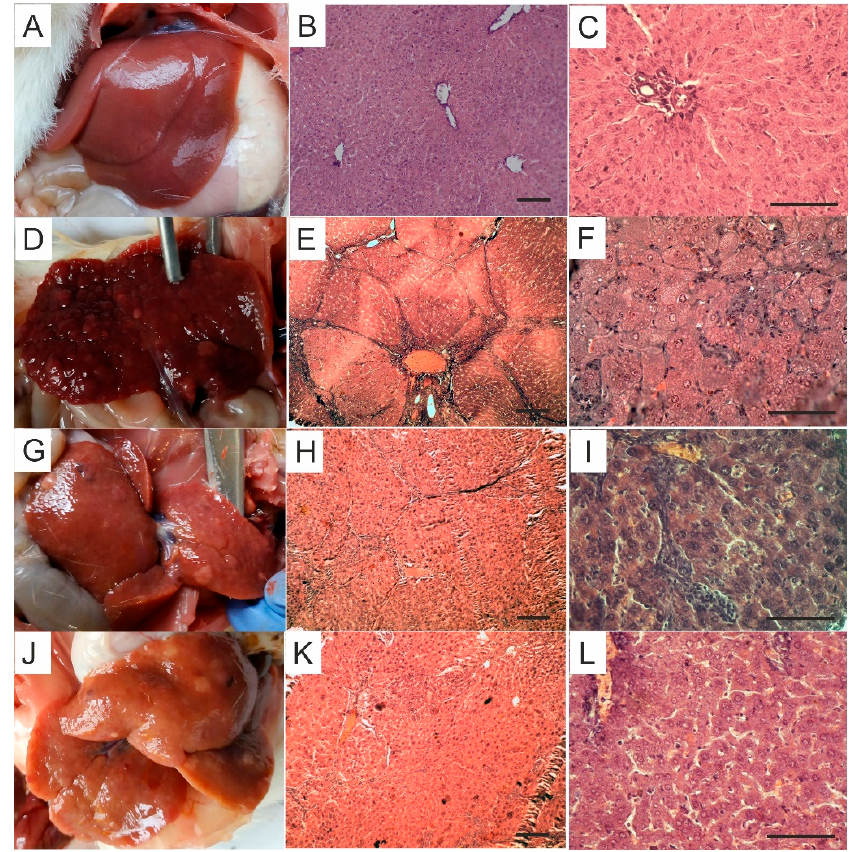
Figure 5. Representative rat livers at the time of the sacrifice ( A , D , G , J ) and H&E staining of liver tissue, magnification ×100 ( B , E , H , K ), scale 200 μ m, and ×400 ( C , F , I , L ), scale 100 μ m: ( A – C )—control; tissue, magnification × 100 ( B , E , H , K ), scale 200 µ m, and × 400 ( C , F , I , L ), scale 100 µ m: ( A – C )—control; ( D – F )—HCC; ( G – I )—HCC + 5FU; ( J – L )—HCC + C 60 FAS. ( D – F )—HCC; ( G – I )—HCC + 5FU; ( J – L )—HCC + C 60